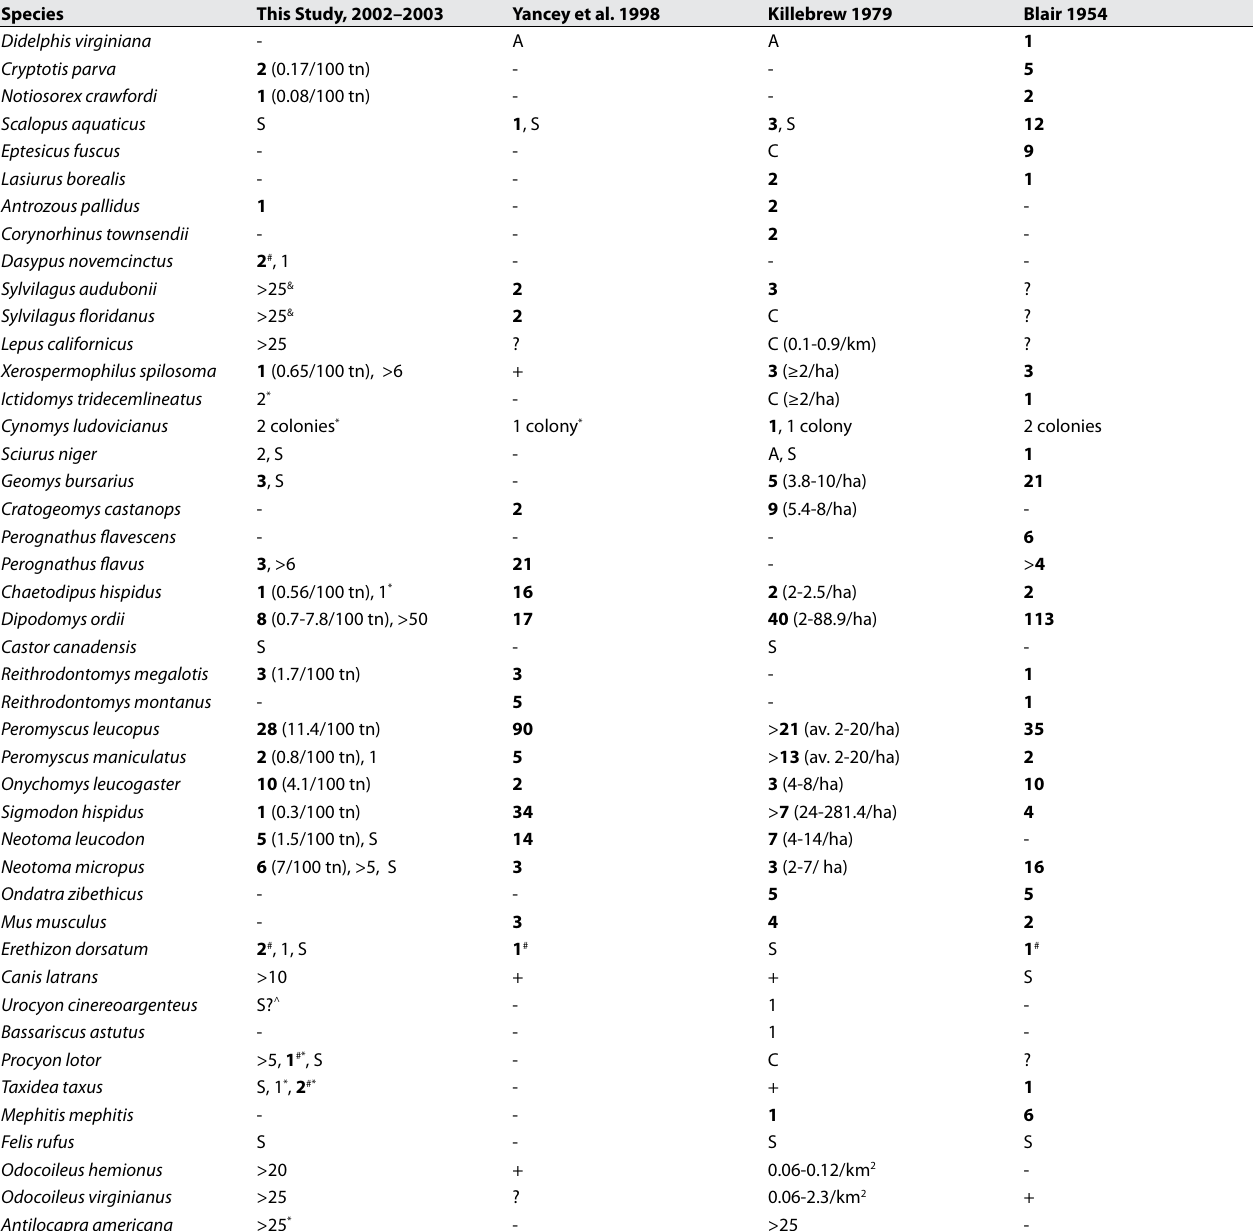
Table 1. Mammalian species detected by the present study, Yancey et al. (1998) and Killebrew (1979) in Lake Meredith National Recreation Area and Alibates Flint Quarries National Monument, and by Blair (1954) at Bugbee Ranch, east of Stinnett. Number of trapped and roadkilled is shown in bold and other observed specimens in normal font; relative species abundance is given where applicable. Legend: (+) present, (-) absent, (A) anecdotal, (C) collected, but no details given (no specimens found in the examined collections), (S) signs (tracks, scat, dens, nests and other signs of activity), (*) outside LMNRA and AFQ, (#) roadkilled or found dead, (^) tracks could not be identified to species, (tn) trap-nights, (&) difficult to distinguish between the two species by visual signs